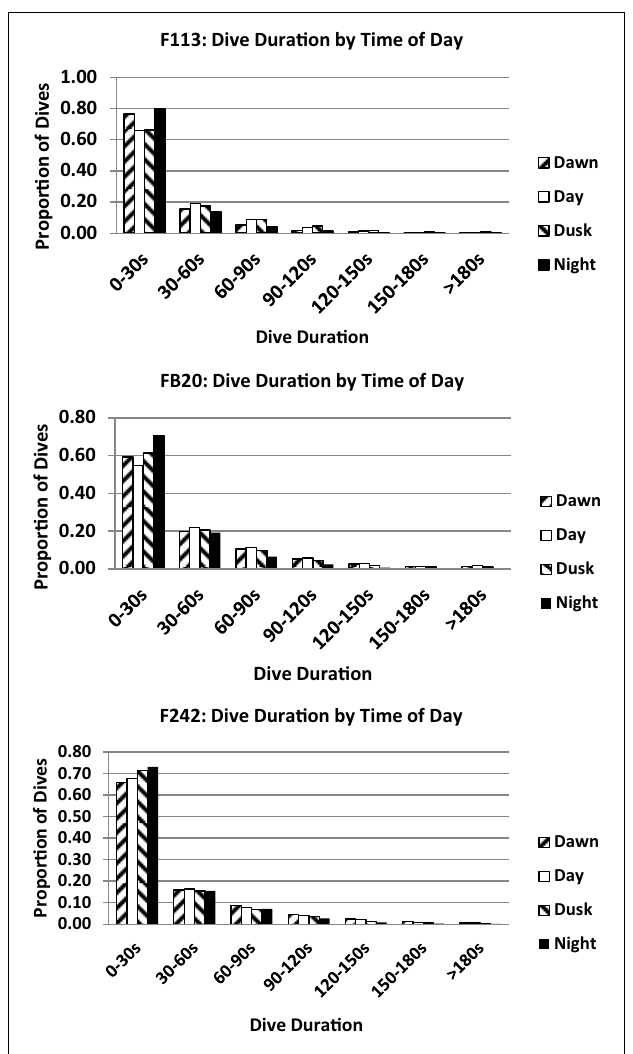
FIGURE 11 | Dive durations relative to time of day for bottlenose dolphin F113, FB20, and F242 .